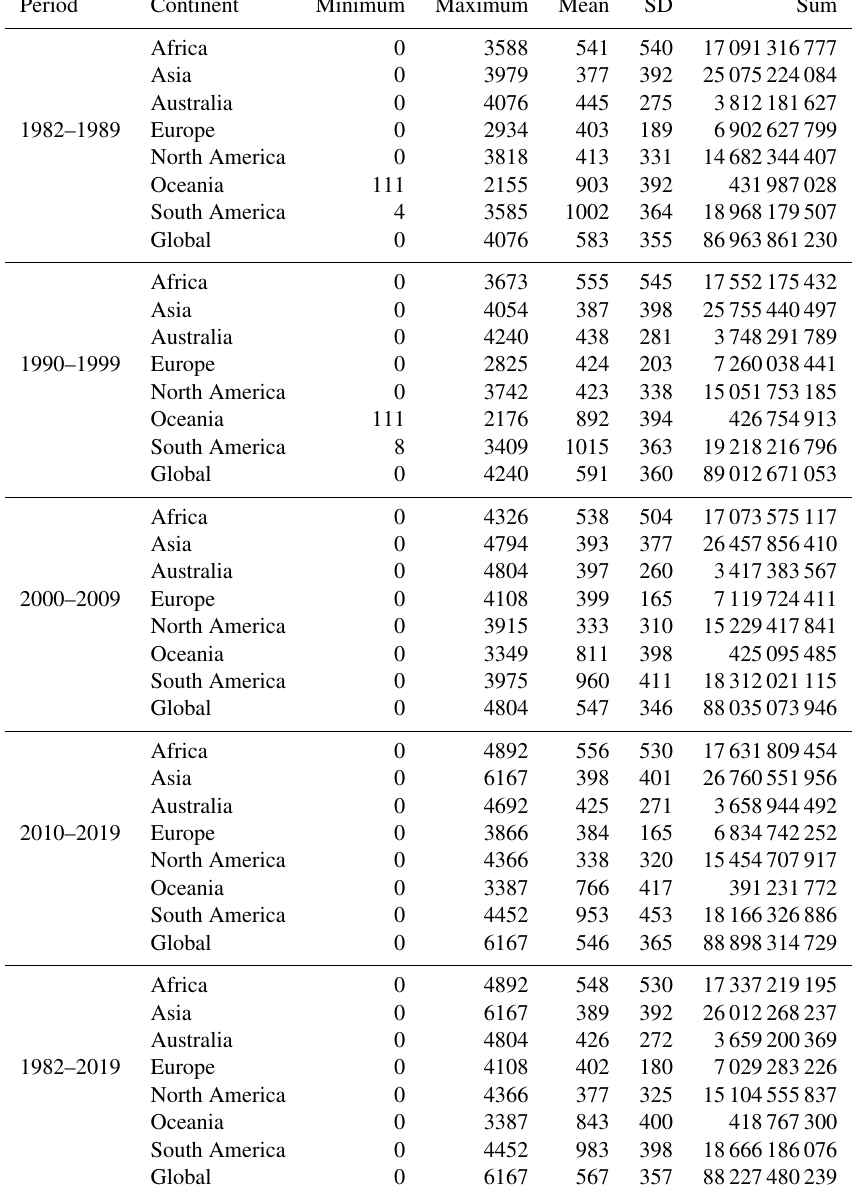
Table 11. Statistics of the decadal and long-term synthesized ET (mm).